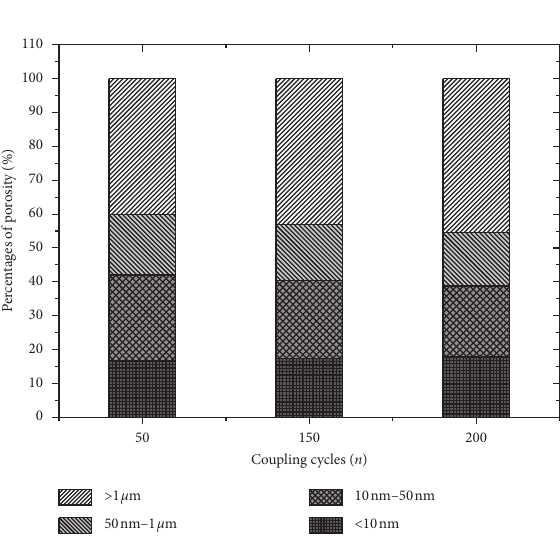
Figure 10: Relationship between pore size distribution and coupling cycles.